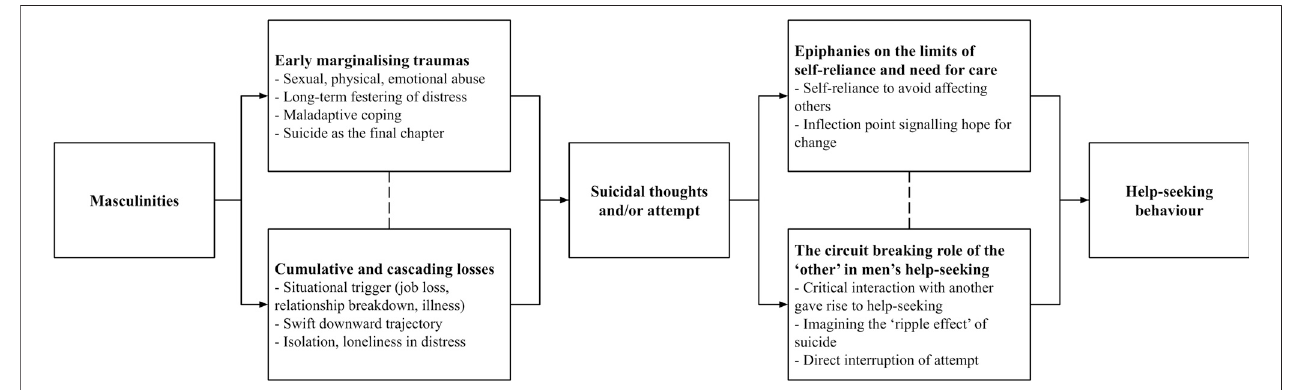
FIGURE 1 | Graphical depiction of themes generated from the data exploring suicidal men ’ s